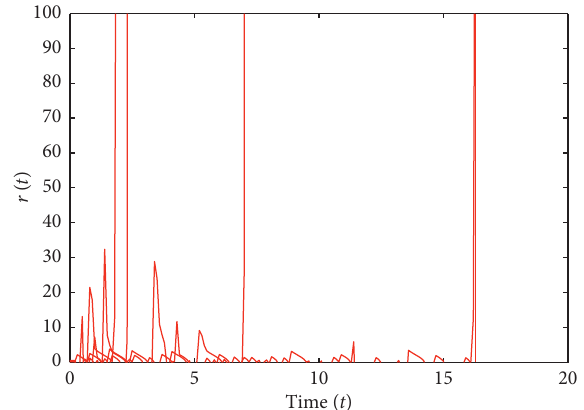
Figure 7: Unstable trajectory of r ( t ) of (45) with θ � 0 . 1, k � 1 . 02.